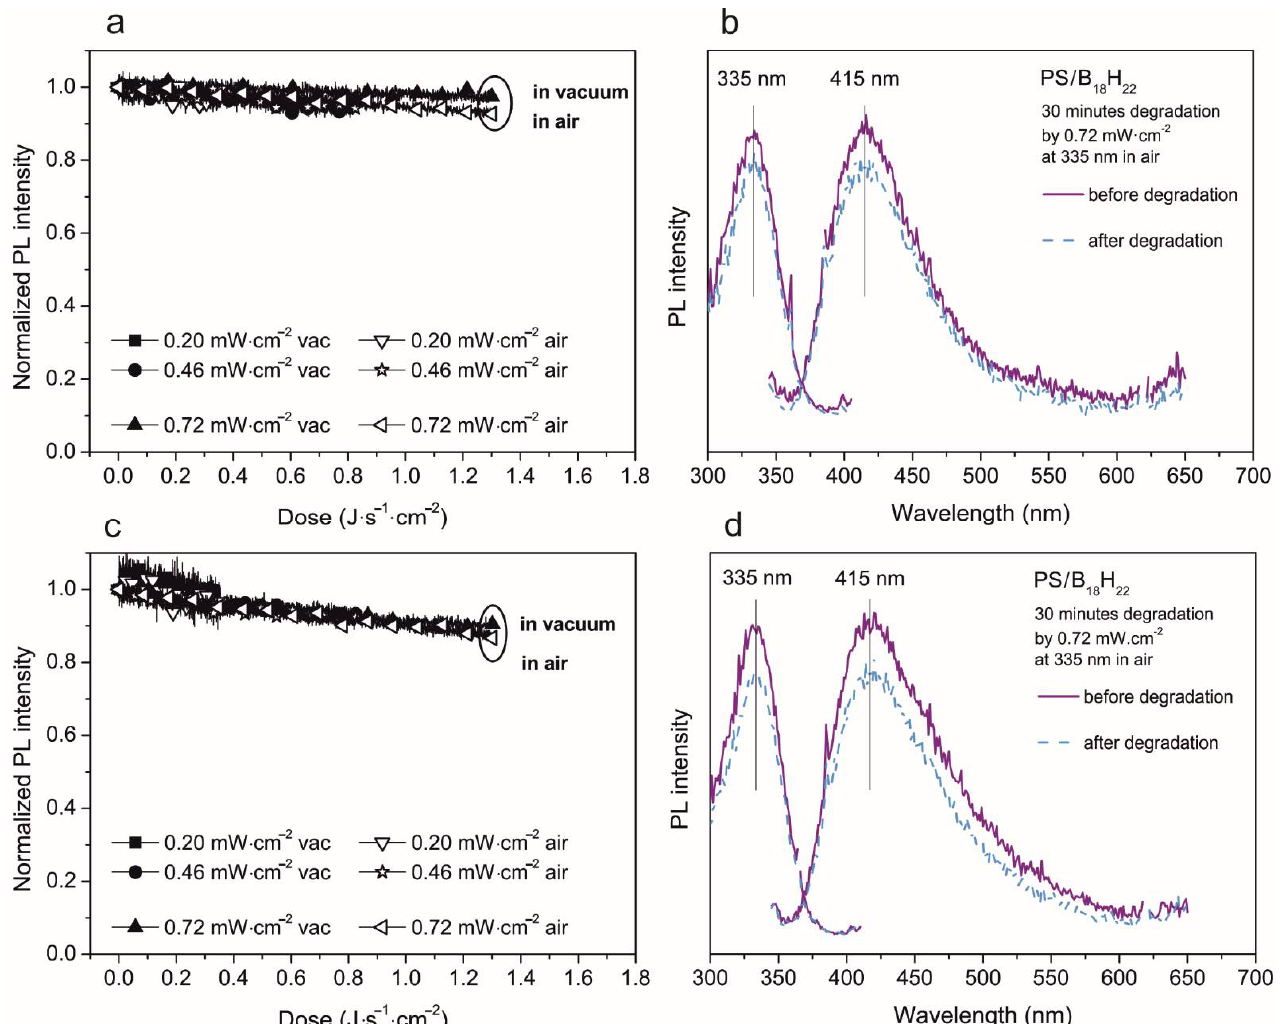
Figure 7. Photodegradation study of 750 nm ( a , b ) and 200 nm ( c , d ) thick film of PS/ anti -B 18 H 22 in ratio 214:1. Left ( a , c )— evolution of normalized PL intensity of emission maxima in both vacuum and air environment depending on the energy dose. The excitation and emission spectra measured before and after 30 min of degradation—right ( b , d ).